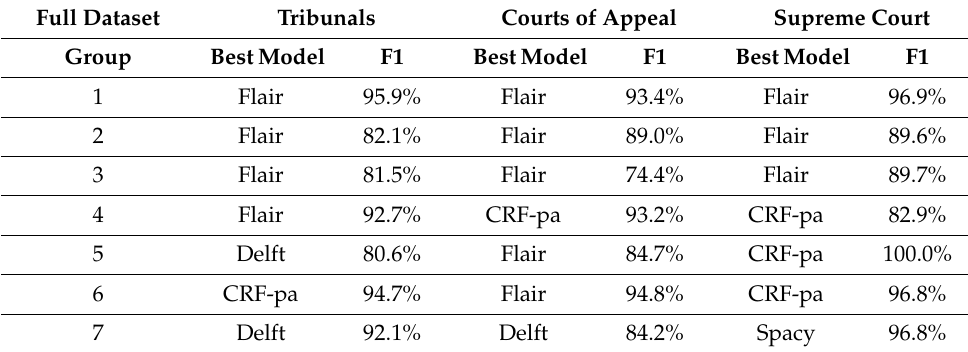
Table 10. Model mix (first